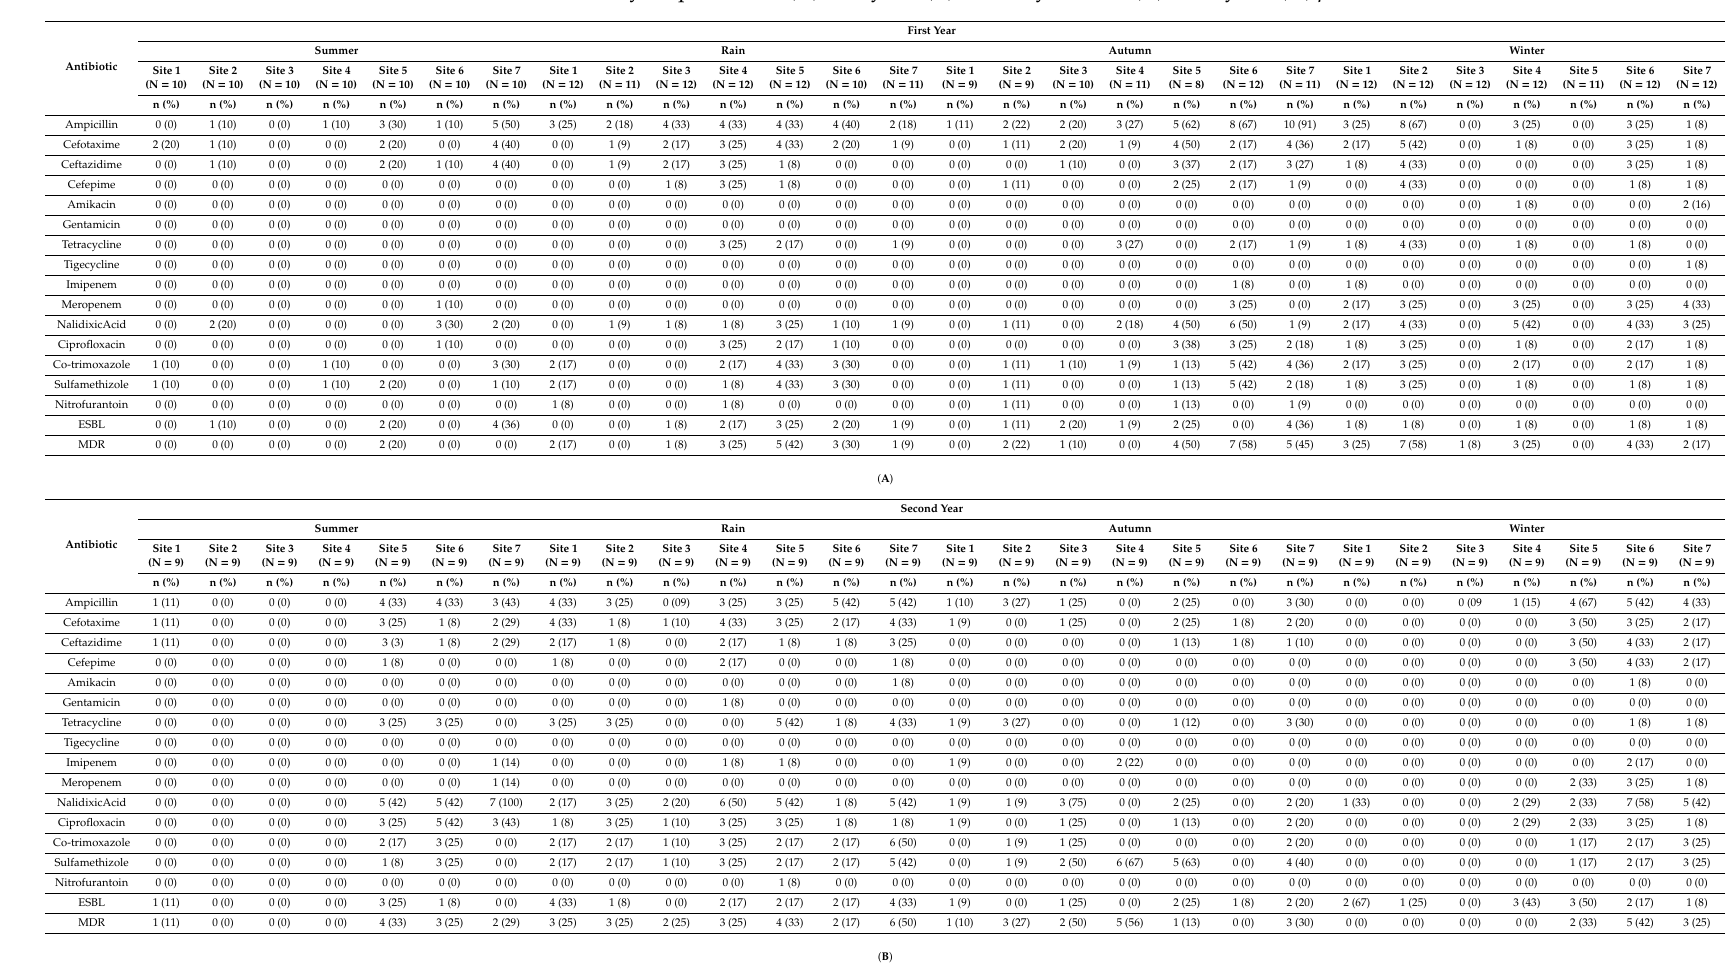
Table 1. Antibiotic resistance patterns in E. coli (857 total number of isolates, 303 in first year, 252 second year, 302 third year) from water samples of the Kshipra river in India in various seasons and at various sites over a 3-year period, in: ( A ) first year; ( B ) second year; and ( C ) third year; ( D ) p -values.